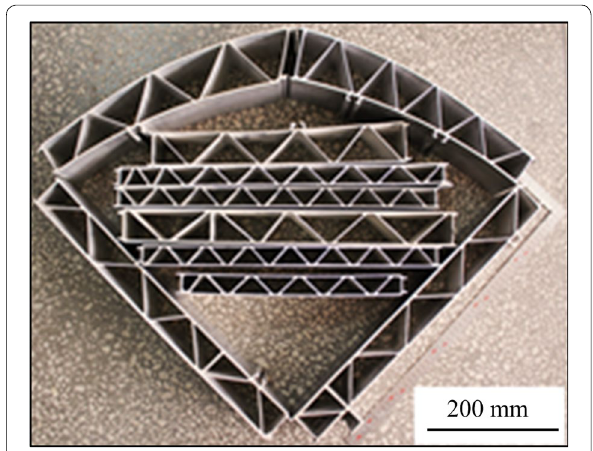
Figure 9 Thin-walled hollow profiles with large and complex cross-sections (Reproduced from Ref.